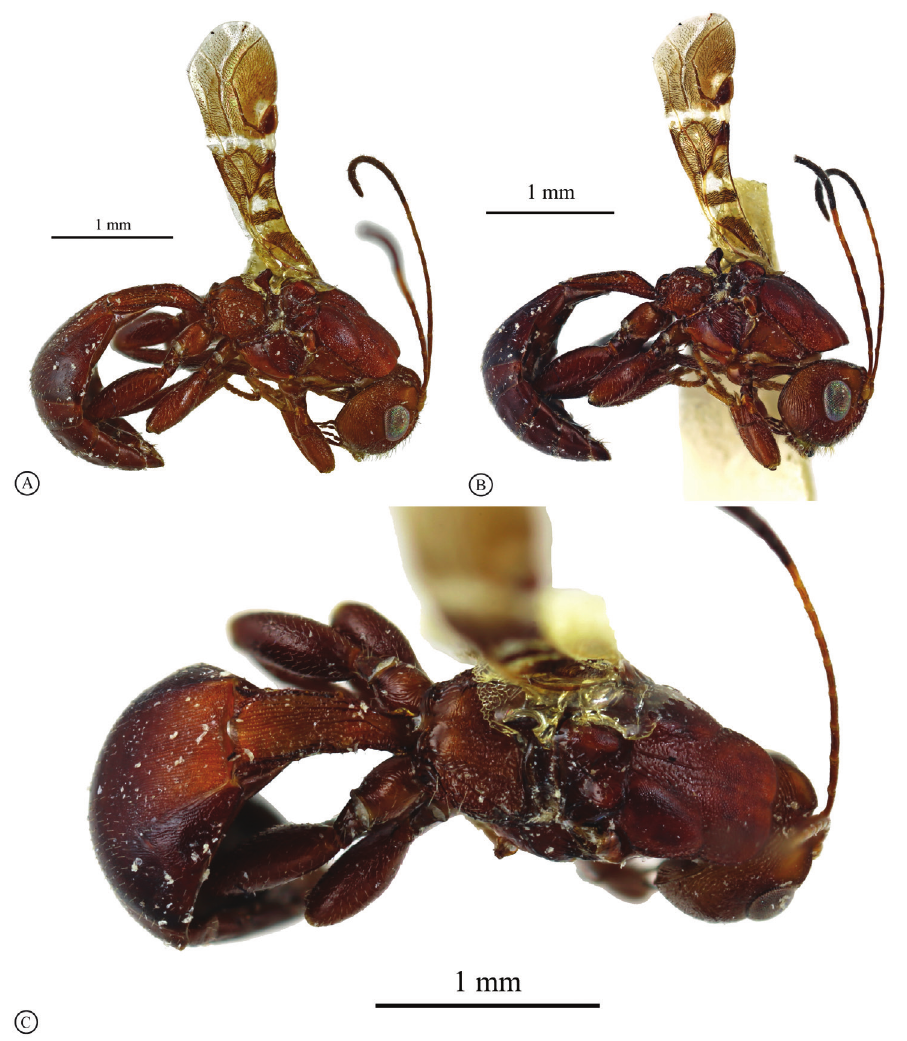
Figure 3. Spathioplites phreneticus , male holotype (MNHN) A habitus, lateral right view B habitus, lateral left view (photo flipped horizontally for comparison with right side depicted in A ) C habitus, dorsal